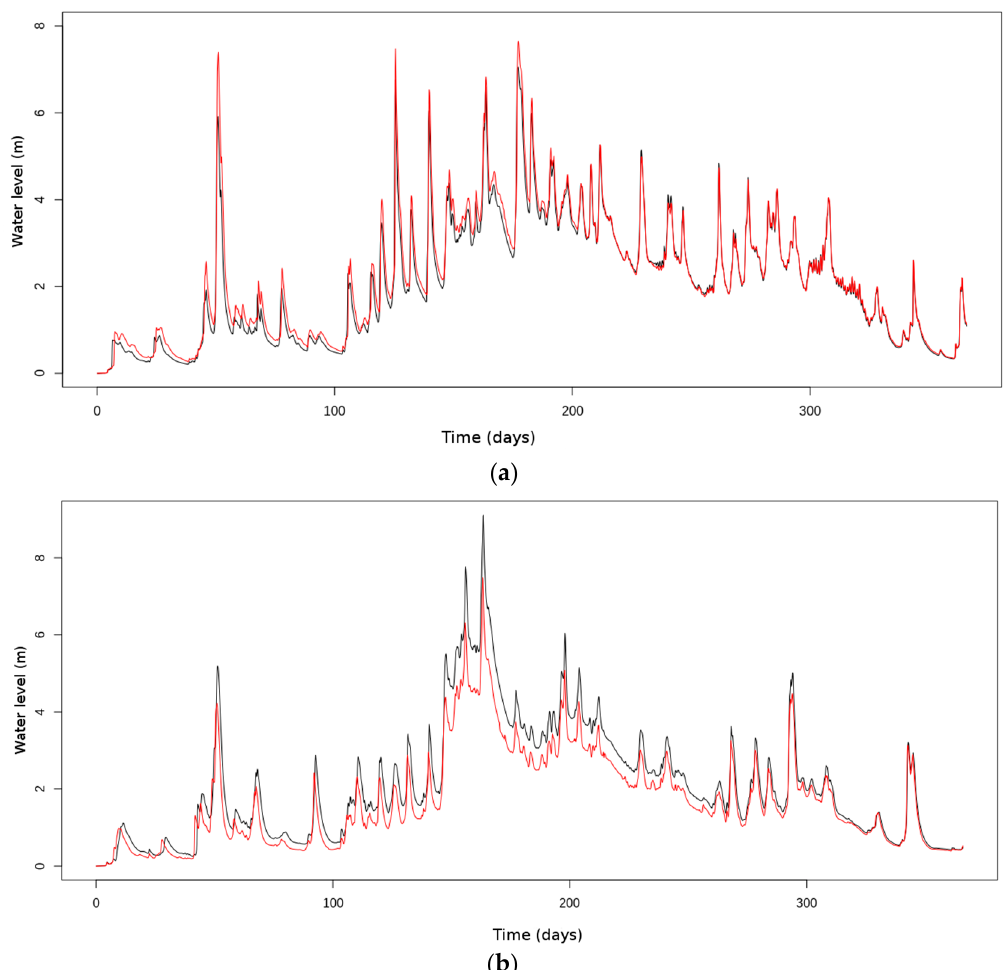
Figure 7. Temporal evolution of the river depth at Lamagist è re ( a ) and Bergerac ( b ), over the period of